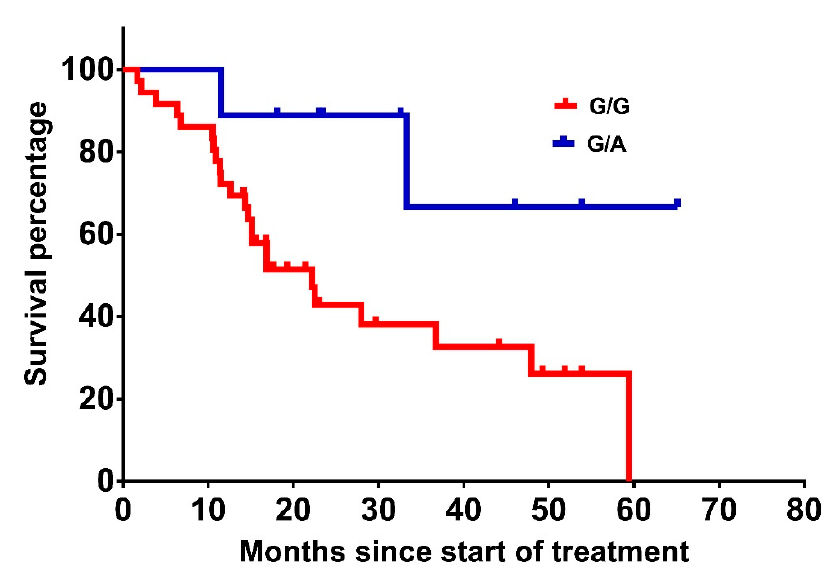
Figure 3. OS from treatment initiation of patients with ICAM-1 rs1799969 G / A vs. G / G (48.7 vs. 29.1 months, p =